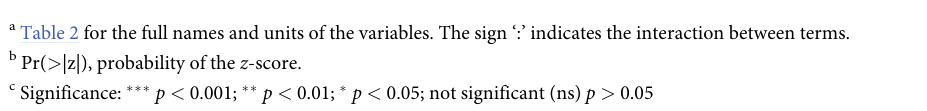
Fig 8 shows the latest banana distribution map created using indicator regression kriging [72] with prediction outputs of the logistic regression model M2-12. This was selected because its predictor variables had a direct role in banana growth unlike in the ensemble model and yet its performance indices were similar to those for the ensemble model with 12 covariates. The map highlights active banana production on the northern and western shores of Lake Victoria, the Southwestern highlands, the foothills of Mount Ruwenzori and of Mount Elgon (Fig 8). This is consistent with what was revealed by the ensemble prediction maps.